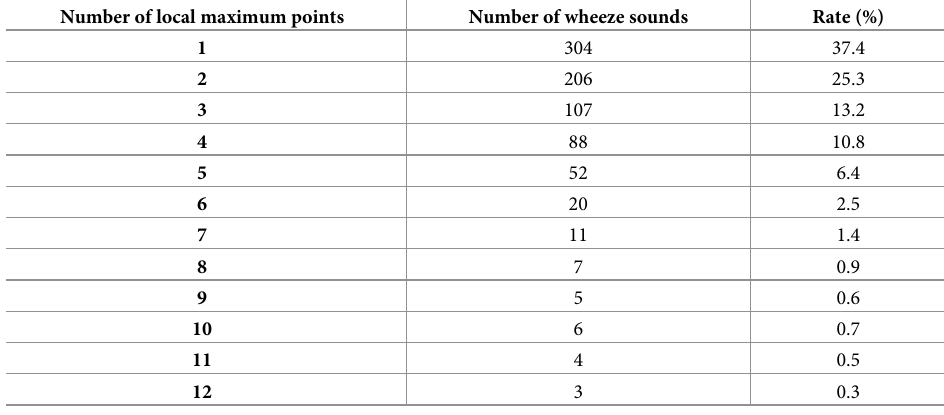
Table 3. Number of local maximum points of wheeze sounds in all recorded sounds.